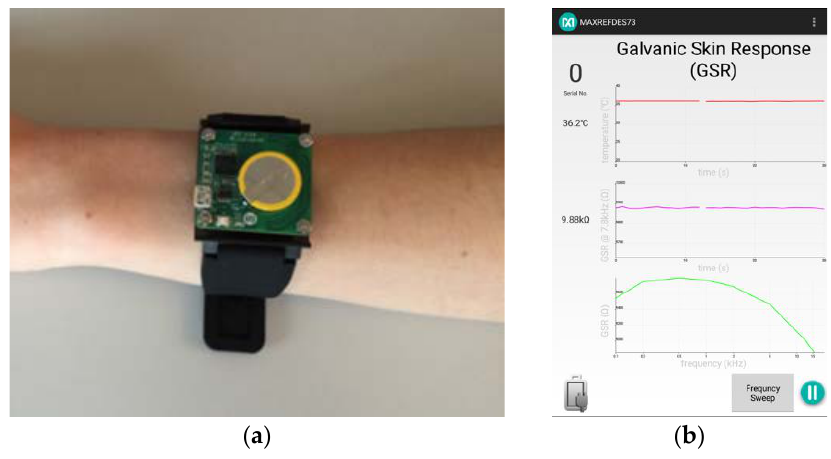
Figure 3. ( a ) Bracelet for the measurement of the galvanic skin response (GSR) parameter; ( b ) MAXREFDES#73 smartphone application screenshot.